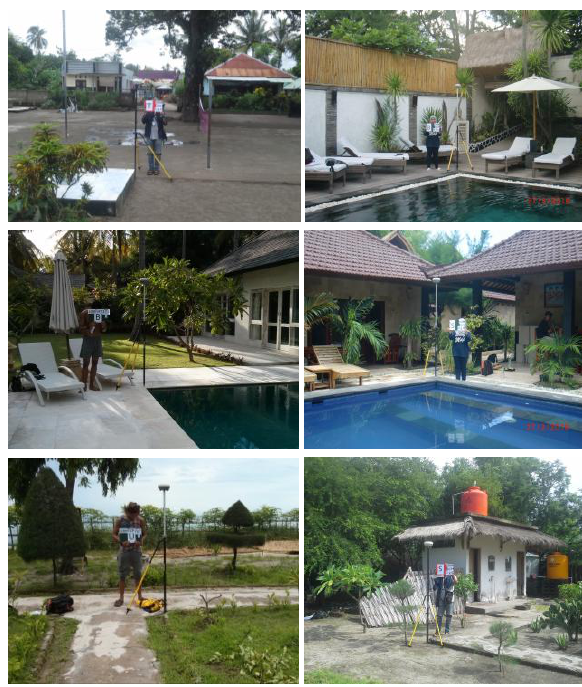
Figure 2. GCP and ICP field measurement in various object There are 6 GCP used for geometric correction of satellite imageries. All of the GCP can be identified in multitemporal stereo satellite imageries. Beside GCP, there are 12 ICP that used to evaluate the quality of DEM. Same like GCP, ICP are acquired though field works by using GPS geodetic dual frequency and static method. GCP and ICP spread evenly throughout image coverage. This is done in order to GCP and ICP may represent the surface terrain of the area taken by it (figure 3).